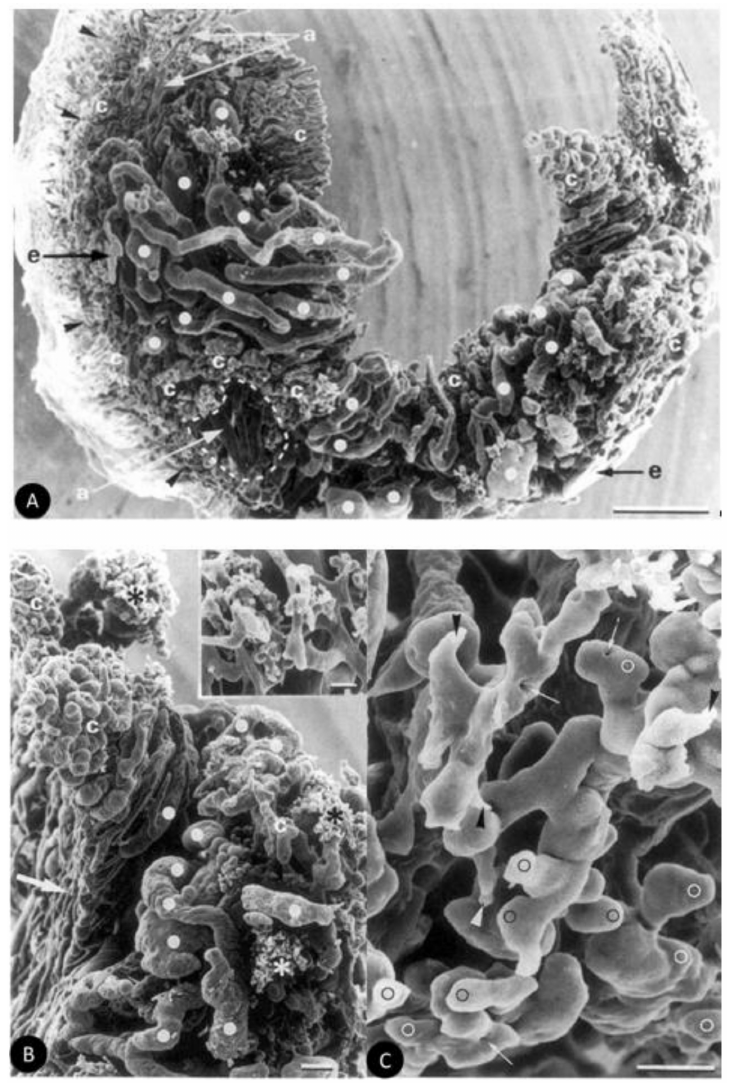
Figure 5. ( A ) Tumor vasculature cast revealing a missing vessel hierarchy and heterogenous vascular density. Strongly dilated venous vessels (full white circles) and capillaries ( c ) predominate over few arterial feeders ( a ) Nodular, nest-like, avascular areas, surrounded by tufts of capillaries with short terminal branches, are marked with a dashed line. The external perimeter of tumor vasculature is indicated with arrowheads. Extravasation of resin is also visible ( e ) Bar = 500 µ m. ( B ) Fragment of intratumor vasculature showing strongly dilated venous vessels (full white circles) interconnected with loops formed by wide sinusoidal capillaries ( c ) Tufts of capillaries with short terminal branches are indicated (asterisks) and shown in higher magnification (inset). Note also the posterior vascular layer of the iris (arrow). Bar = 100gm and 50 gm, respectively. ( C ) Vascular sprouts (arrowheads) and globular outgrowths (white circles) on the proliferating, dilated tumor capillaries. Note also the tiny holes (arrows) typical of the intussusceptive angiogenesis. Bar = 500 µ m. Reproduced with permission from Annals of Anatomy [137]. Copyright 2001 Elas,